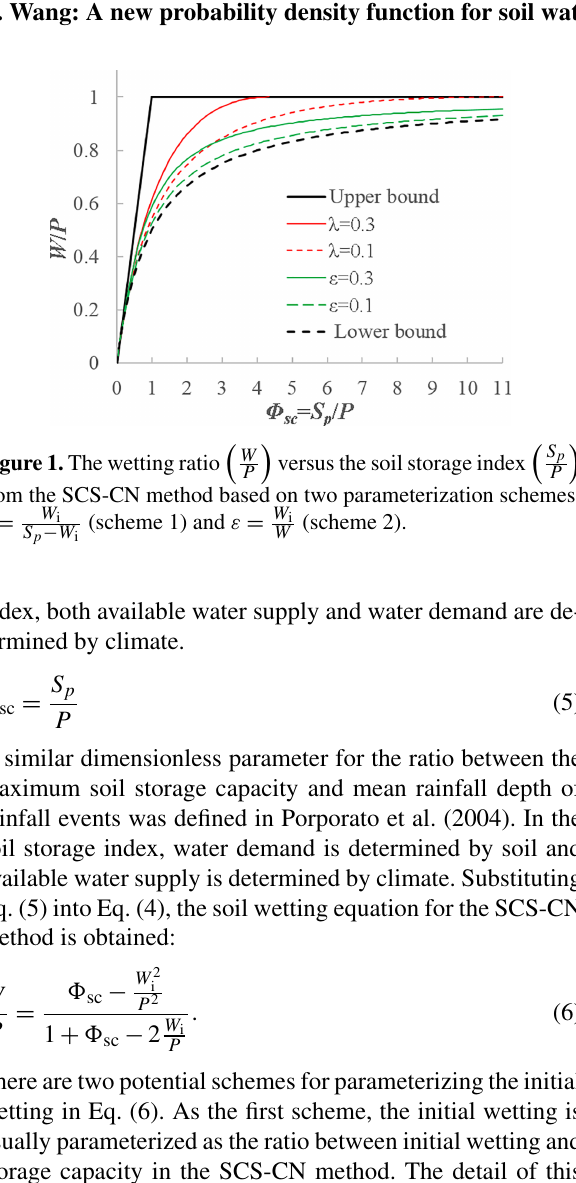
(cid:16) S (cid:17) p P